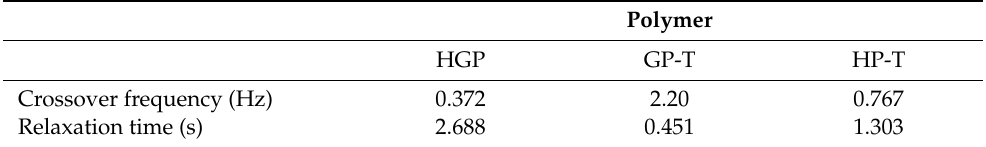
Figure 10. G’ and G” varying as a function of angular frequency for three polymers. ( a ) HGP, ( b ) GP-T, ( c ) HP-T.